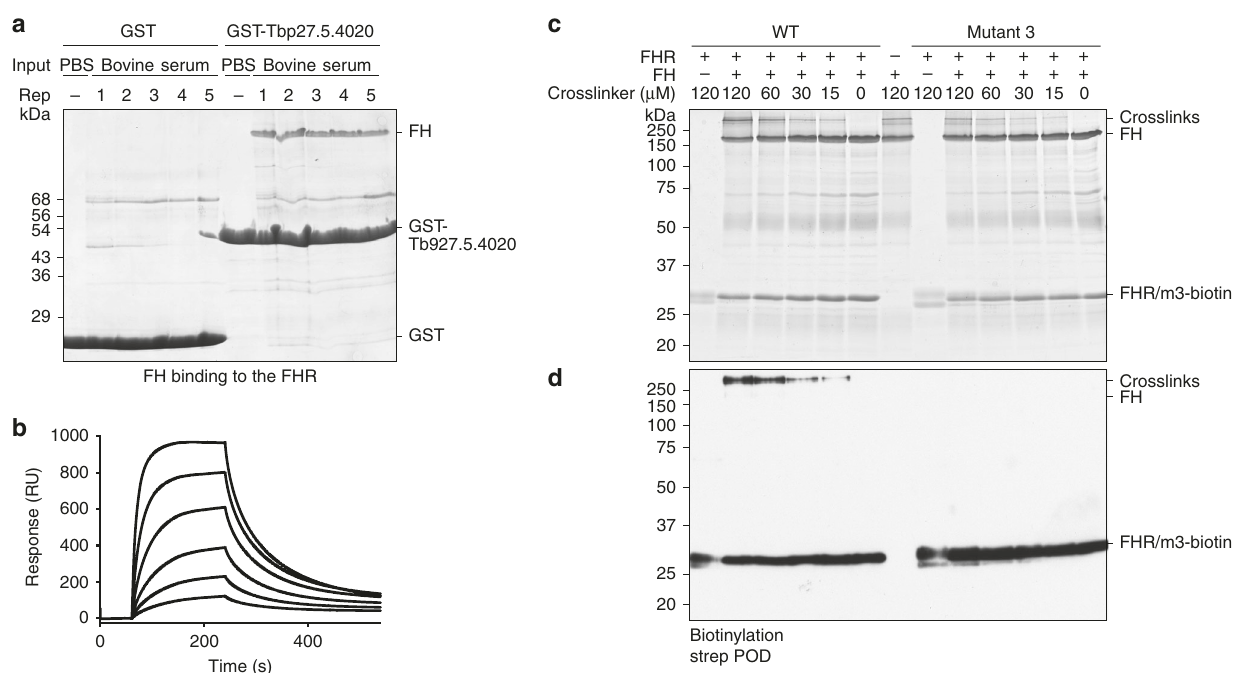
Fig. 1 Identi fi cation of the T. brucei FHR and its interaction interface with FH. a SDS-PAGE analysis of pulldowns from bovine serum were performed with GST or GST-Tb927.5.4020 immobilized on beads in fi ve replicates or with a phosphate buffered saline (PBS) control. b SPR-binding data for C-terminally biotinylated FHR (450 RU) bound to a streptavidin chip and twofold dilutions of FH puri fi ed from bovine serum (1 μ M highest concentration). Data shown are representative of three repeats. c SDS-PAGE analysis of cross-linking experiment using D12 disuccimidyl suberate (DSS) to probe the interaction between FHR and FH. FHR and mutant 3 were biotinylated at the C terminus and incubated with FH prior to the addition of the cross-linker in a dilution series as shown. d Western blotting of samples in c , probed with streptavidin peroxidase. Source data are provided as a Source Data fi le.